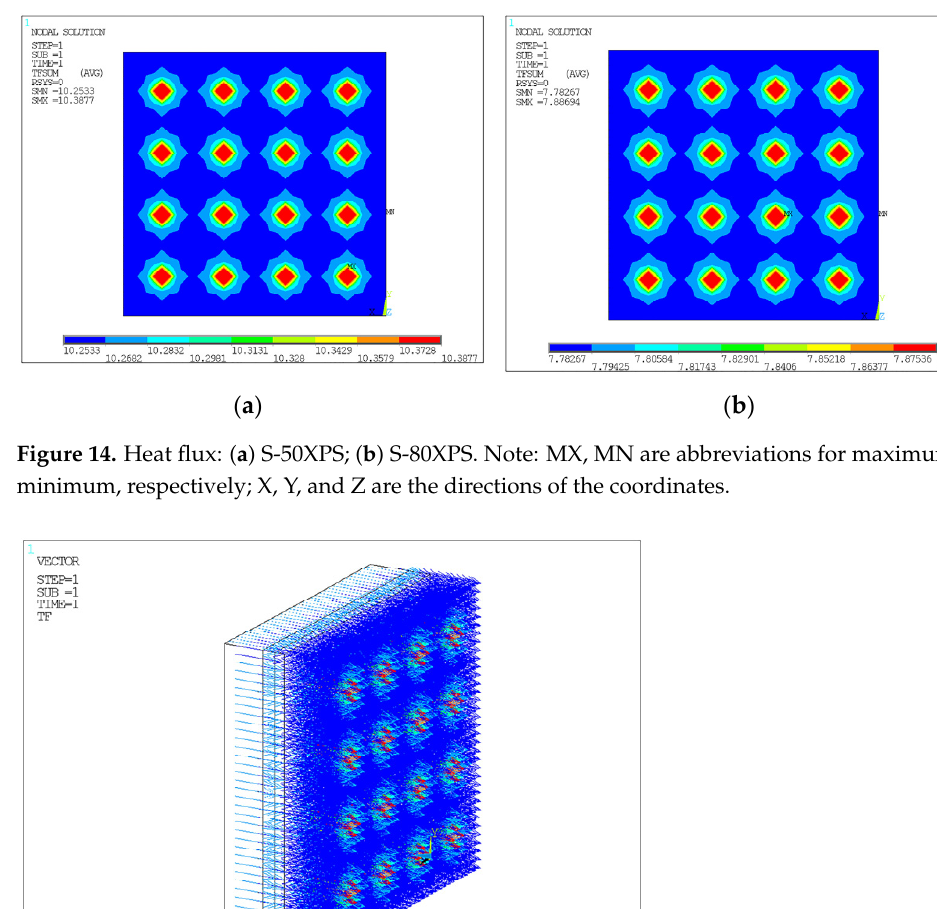
Figure 15. S-80XPS heat flux vector diagram. Note: X, Y, and Z are the directions of the coordi- nates.